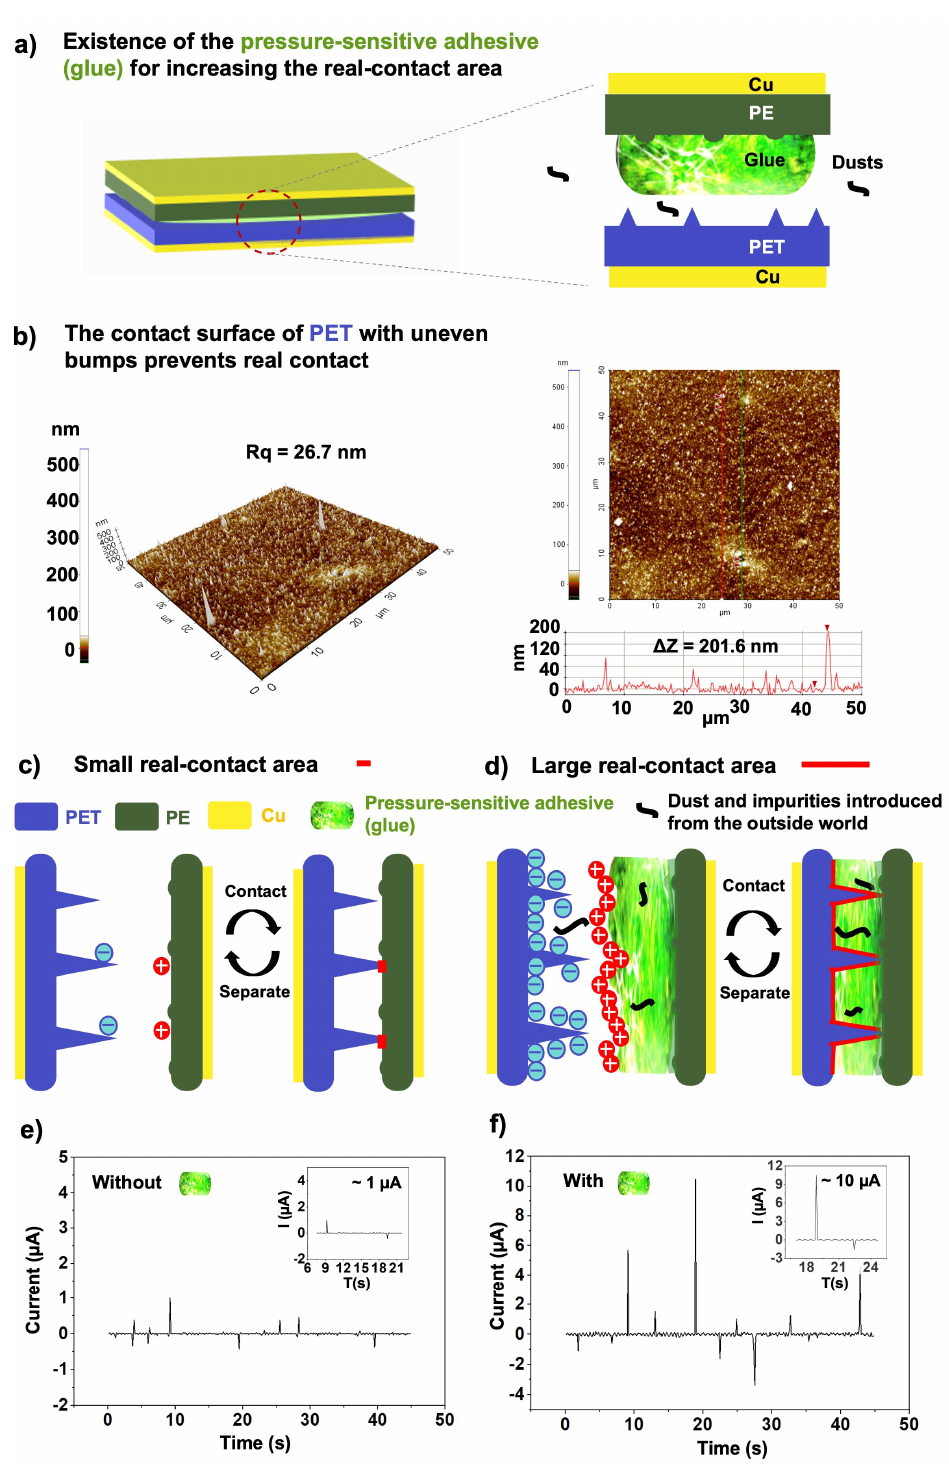
Figure 5. The pressure-sensitive adhesive used for increasing the real contact area of the TENG. ( a ) Schematic showing the TENG with a triboelectric interface formed by pressure-sensitive adhesive. ( b ) Atomic force microscopy (AFM) images and cross-sectional analysis showing the surface mor- phology of a normal PET film. ( c , d ) Schematic showing how the adhesive increases the real contact area when two normal polymer surfaces are in contact with a plastic substrate with a normal surface roughness. The output current of the TENG ( e ) with and ( f ) without the adhesive.